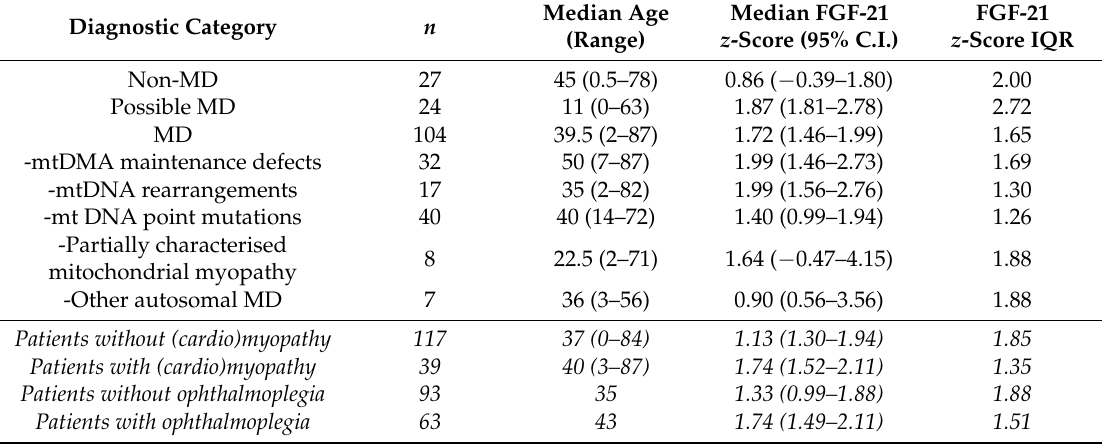
Table 1. Demographics and FGF-21 data in patients diagnosed with mitochondrial disease (MD), those without MD (non-MD), and patients with a possibility of having MD. FGF-21 z -scores are based on log-transformed values. Data on categories of MD, as well as those on patients with and without (cardio) myopathy and ophthalmoplegia (progressive external ophthalmoplegia or ptosis), have been